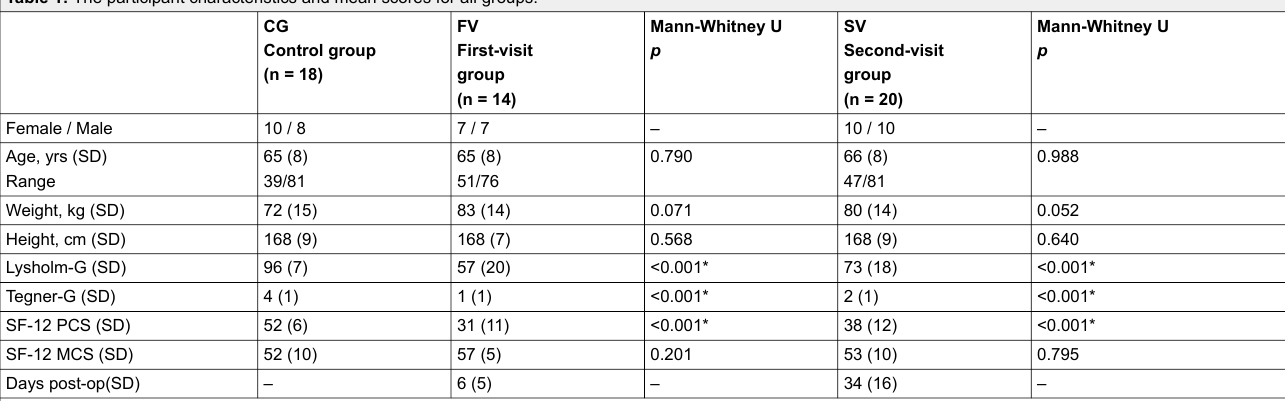
Table 1: The participant characteristics and mean scores for all groups.